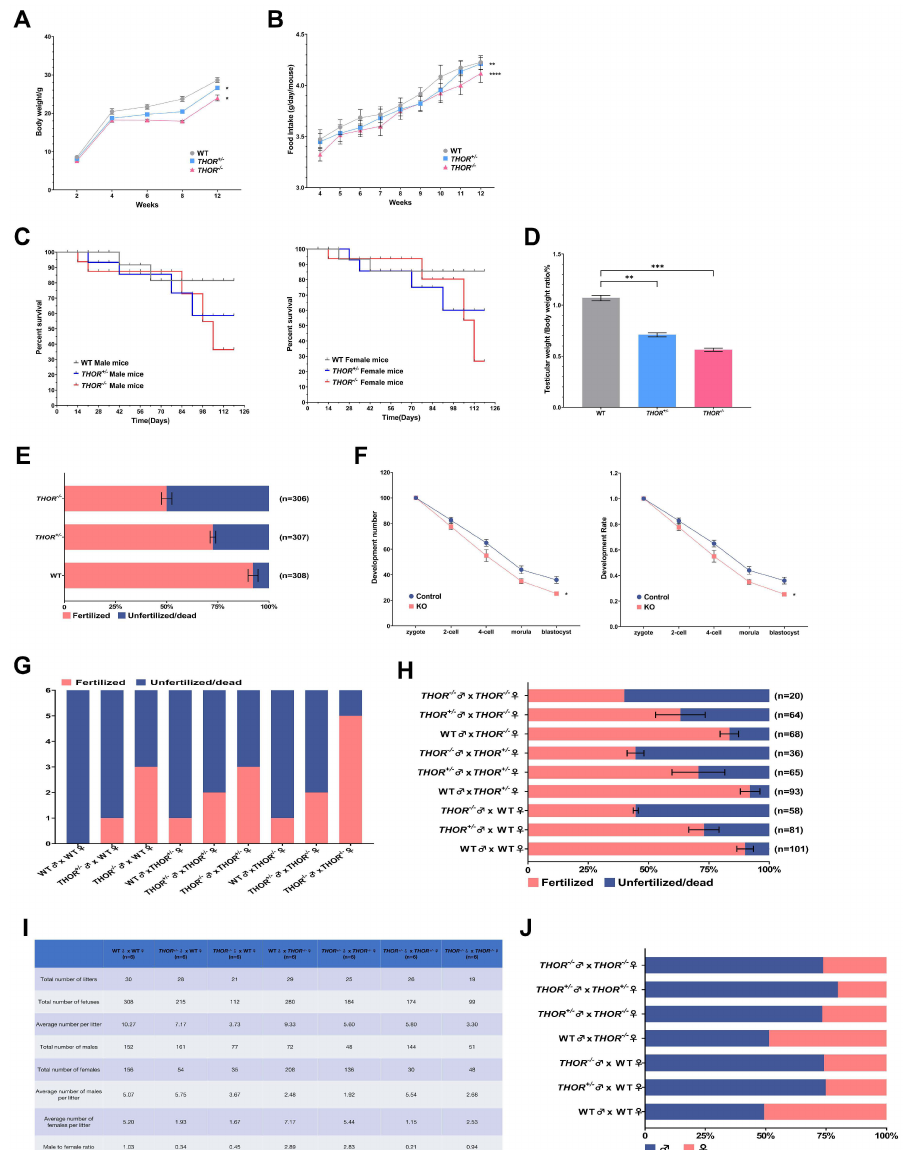
Figure 3. THOR -deficient mice exhibit decreased fertility and an imbalance between females and males. ( A ) Comparison of the body weights of WT and THOR -deficient male mice. * indicates p ≤ 0.05 as determined by a t -test. The data are shown as the mean ± SD from two independent experiments. ( B ) Food intake changes in the mice. ** indicates p ≤ 0.01 as determined by a t -test, and **** indicates p ≤ 0.0001 as determined by a t -test. The data are shown as the mean ± SD from two independent experiments. ( C ) Survival curve statistics of WT and THOR -deficient mice. Ten mice in each group. ( D ) The testes/body weights of WT and THOR -deficient mice. ** indicates p ≤ 0.01 as determined by a t -test, and *** indicates p < 0.001 as determined by a t -test. The data are shown as the mean ± SD from two independent experiments. ( E ) The fertilization rates of WT female mouse oocytes after in vitro fertilization with sperm from WT and THOR -deficient male mice. ( F ) Embryonic development after THOR deletion by microinjection of the sgRNA and Cas9 mRNA mixture. Each group of 100 oospheres, repeat 3 times. * indicates p ≤ 0.05 as determined by a t -test. The data are shown as the mean ± SD from two independent experiments. ( G ) Female mice in estrus were mated with male mice of different genotypes, and the vaginal suppositories were counted the next morning. Six pairs of mice in each group. ( H ) Female mice in estrus were mated with male mice of different genotypes, and the fertilization of female mice with vaginal suppositories was assessed the next morning. n is the total number of embryos in female mice whose vaginal plugs were detected after mating in Figure 3G. Cultured in vitro for 24 h developed into 2-cell as a fertilization mark. ( I ) The reproductive statuses of the offspring of mice with different genotypes after 6 months of mating at a 1:1 ratio. ( J ) The female-to-male ratio of offspring from mice of different genotypes after 6 months of mating at a 1:1